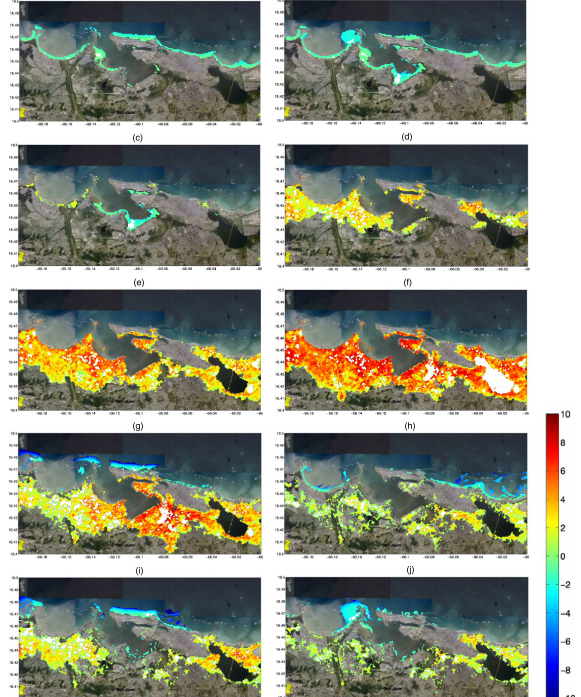
Fig. 14. Tsunami inundation near Isabela on PRNS (Fig. 12b), in meters of ( > 0) elevation above ground, or ( < 0) dry bottom from water withdrawal, due to the M =9.1 co-seismic source (same case as in Figs. 6, 7, 11 in a fine grid). Time of plots: (a) 0, (b) 2, (c) 5, (d) 7, (e) 9, (f) 11, (g) 14, (h) 16, (i) 18, (j) 20min after the arrival of the tsunami onshore (about 350s after the